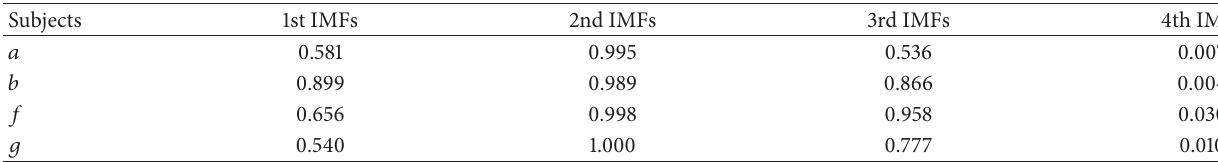
Table 1: 𝑝 values comparing the power spectra of the first four IMFs identified by two approaches.